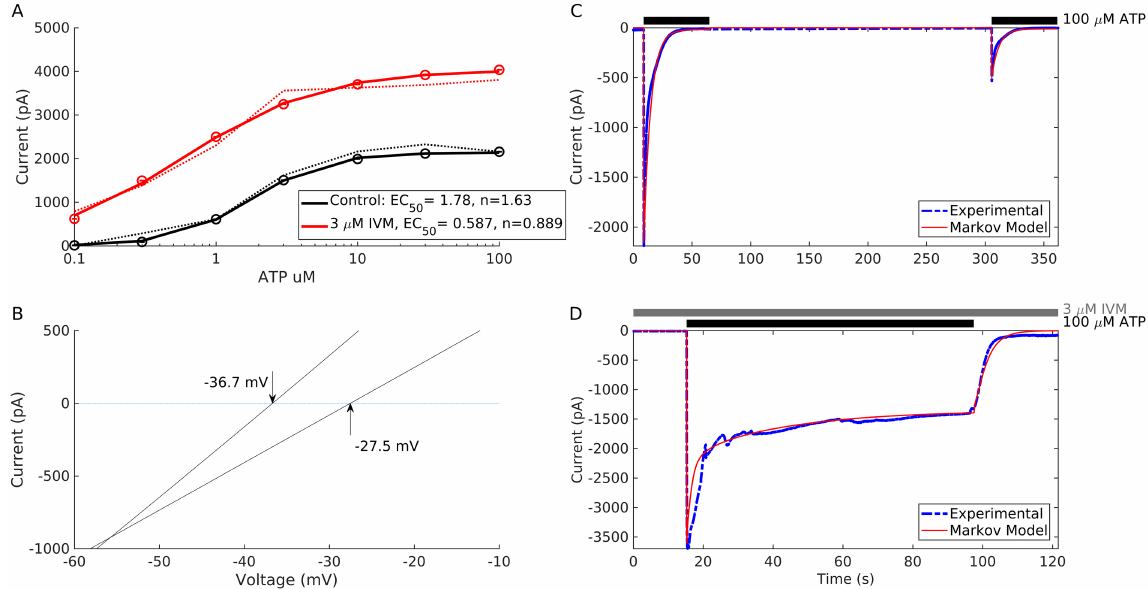
Fig 5. Outcomes of the two-layer model determined by the MCMC fitting to the pulse and prolonged protocols. (A) ATP- dependent concentration-responsecurves in the absence (black) and presence(red) of 3 μ M IVM applied30 s before ATP stimulation.CalculatedEC 50 and Hill coefficients (n) in the absenceof IVM were 1.78 μ M and 1.63, respectively,and in the presence of IVM were 0.587 μ M and 0.889, respectively.Dotted lines are experimental data. (B) The first and last I-V curves showingthe decreasein their slopes and a positive shift in reversalpotentialupon stimulationwith 100 μ M ATP for 10 s in the presenceof 3 μ M IVM applied20 s before ATP stimulation. The bath medium had Na + replacedby NMDG + modeledby setting E 1 = − 93.5 mV and E 2 = − 5.1 mV. Voltage was ramped from − 80 mV to + 80 mV twice per second from a holdingpotential of − 60 mV. (C) Two prolonged applications of 100 μ M ATP separated by a 4 min washout periodin the absenceof IVM. (D) Prolongedapplicationof 100 μ M ATP produced by the model in the presenceof 3 μ M IVM. Dashedblue lines, experimental recordings;solid red lines, simulations. All experimental data were derived from [20].